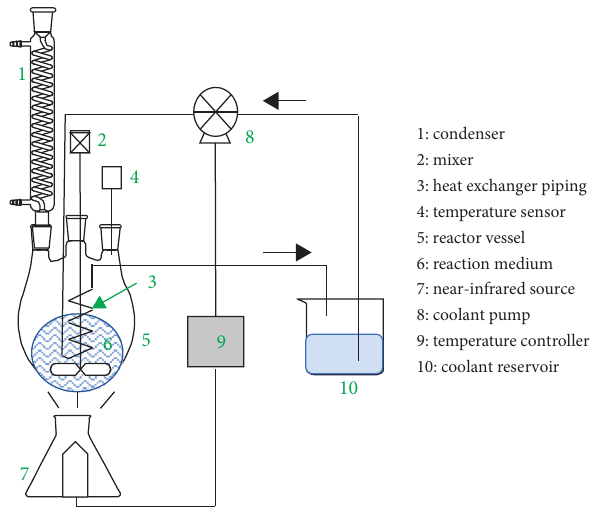
Figure 10: Scheme of a general IRAE